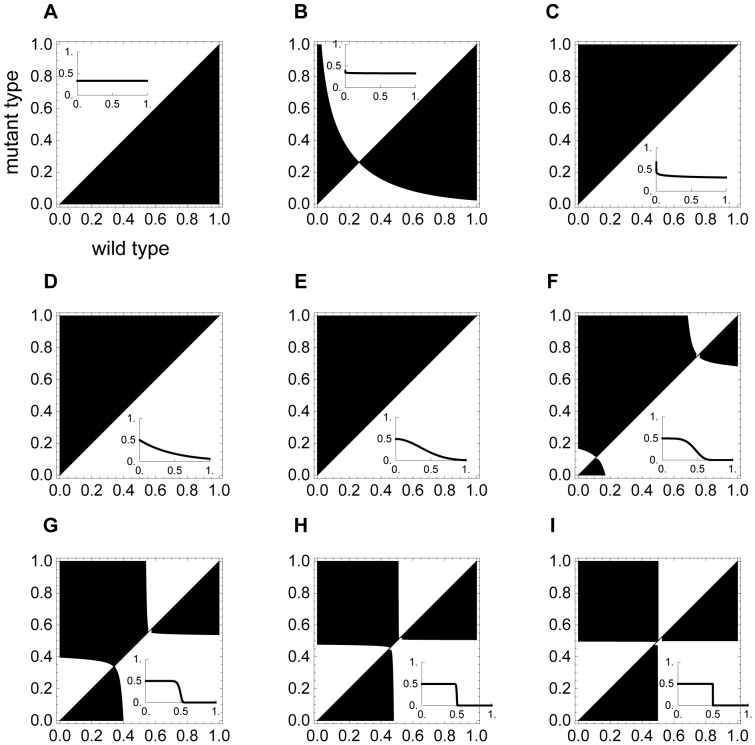
Pairwise invasibility plots (PIPs) of cooperation level when other traits are not adaptive.The horizontal and vertical axes represent the wild and mutant type, respectively. The black region means the mutant type can invade the population occupied by the wild type (I >0 in Eq. 6), and the white region means the mutant type cannot invade (I <0). The black diagonal means I = 0. The small graph in each figure presents the punishment cost assumed in each of (A)–(I). In each small graph, the horizontal and vertical axes represent the opponent’s cooperation level and the punishment cost of the focal player. Parameters are z = 8, r = 3, β = 10, d = 0.1, and u = 0.5; (A) a = 0.0 and f = 0.9; (B) a = 0.01 and f = 0.9; (C) a = 0.07 and f = 0.9; (D) a = 1 and f = 0.5; (E) a = 2 and f = 0.9; (F) a = 5 and f = 0.9; (G) a = 20 and f = 0.9; (H) a = 100 and f = 0.9; and (I) a = 1,000 and f = 0.9.